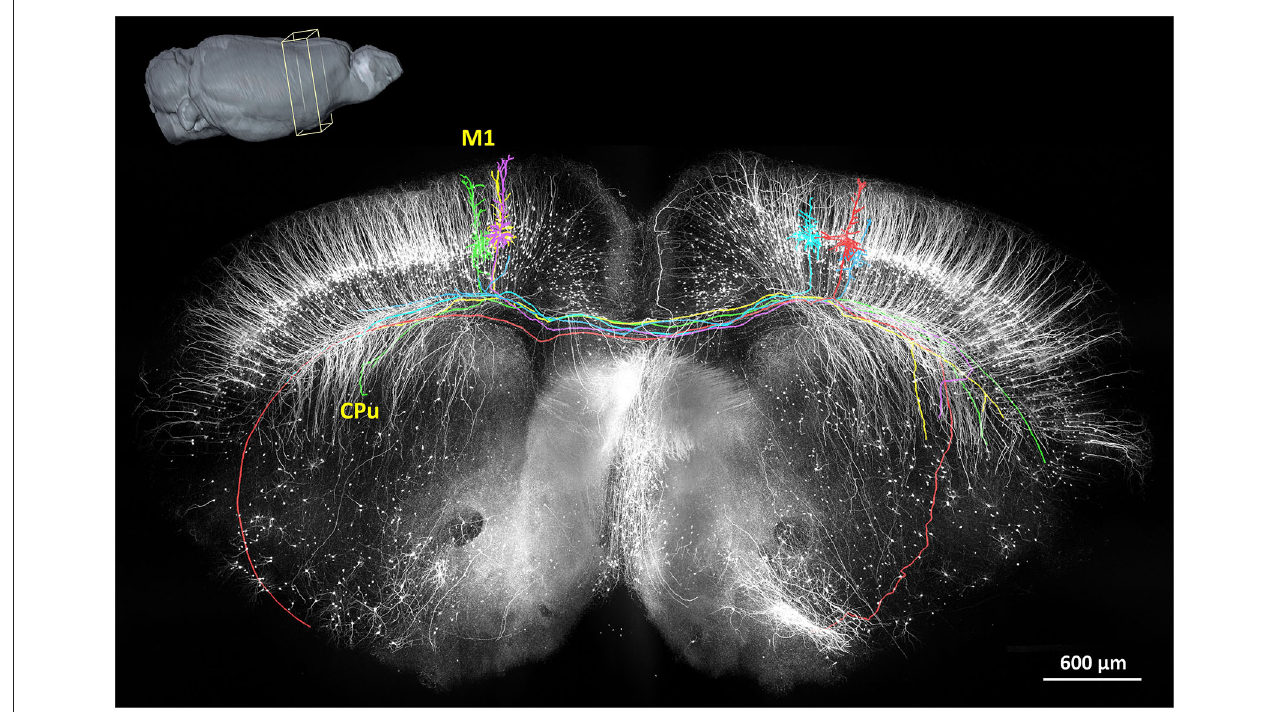
segmented and traced, indicated in different colors. Axon arbors extend in the ipsilateral hemisphere and to the caudate putamen in the contralateral hemisphere via the corpus callosum. Redrawn from the imaging dataset published in Gong et al.